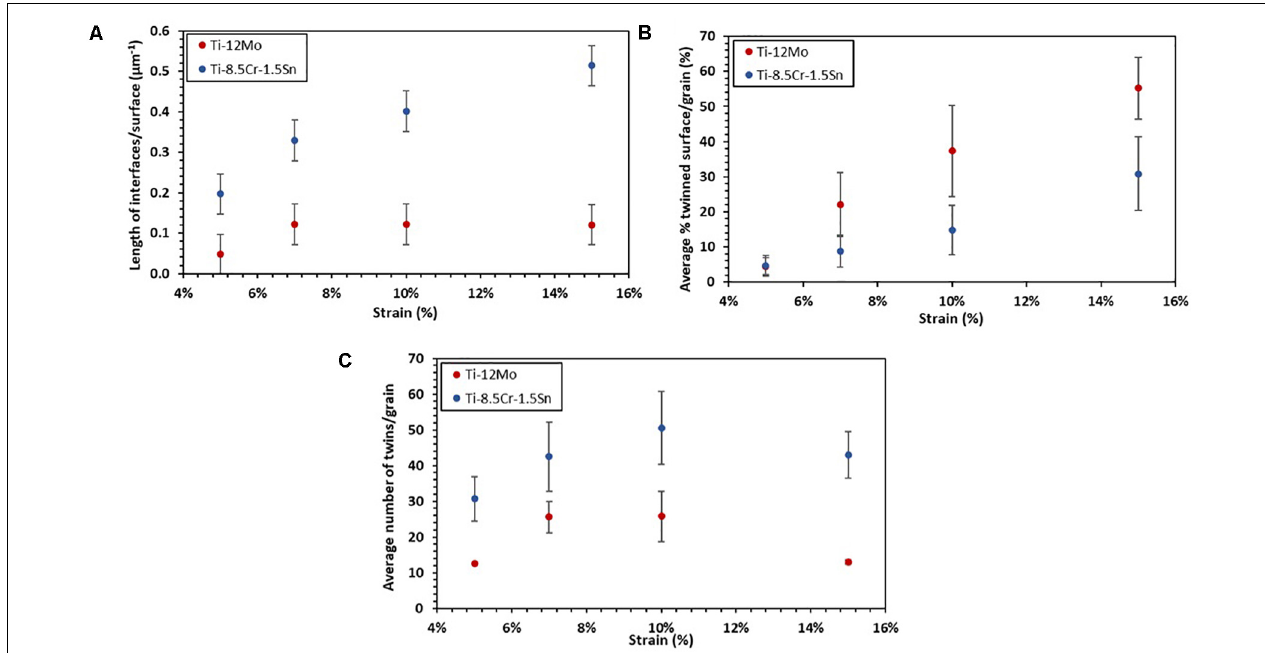
FIGURE 7 | Evolution of (A) length of interfaces per surface unity, (B) percentage of twinned surface per grain, and (C) average number of twins per grain for Ti–12Mo (in red) and Ti–8.5Cr–1.5Sn (in